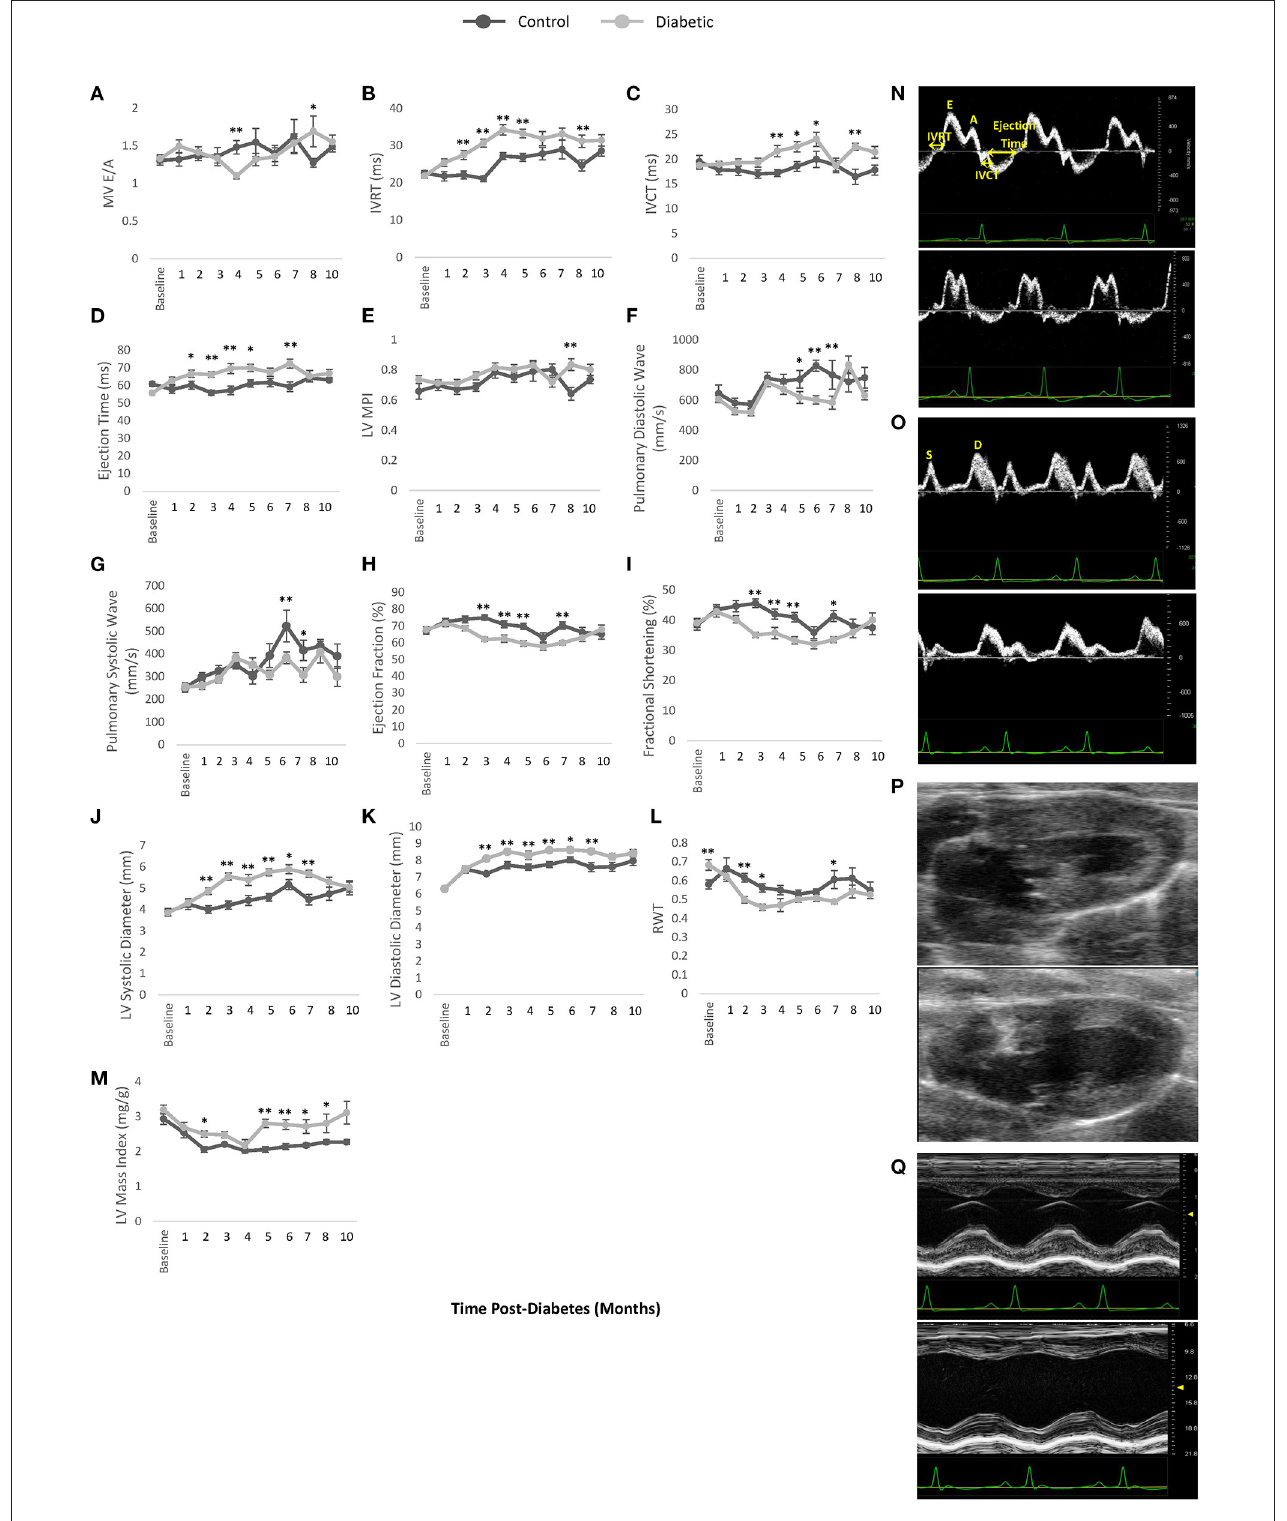
FIGURE 5 | Cardiac LV function and dimensions measured by pulsed wave Doppler and M-mode echocardiography. (A) Mitral valve E/A ratio representing the ratio between peak blood velocity in the left ventricle (LV) during early diastole to peak blood velocity in the LV at late diastole. (B) Isovolumetric relaxation time (IVRT). (C) Isovolumetric contraction time (IVCT). (D) LV ejection time. (E) LV myocardial performance index (MPI). (F) Pulmonary peak diastolic (D) venous wave. (G) Pulmonary